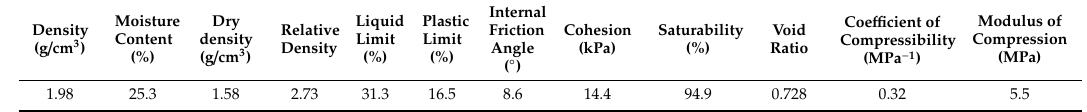
Figure 8. Preparation of foundation soil: ( a ) Layered with soil, ( b ) add water wetting, ( c ) uniform infiltration, and ( d ) rest foundation soil. Table 3. Physical properties of soil.